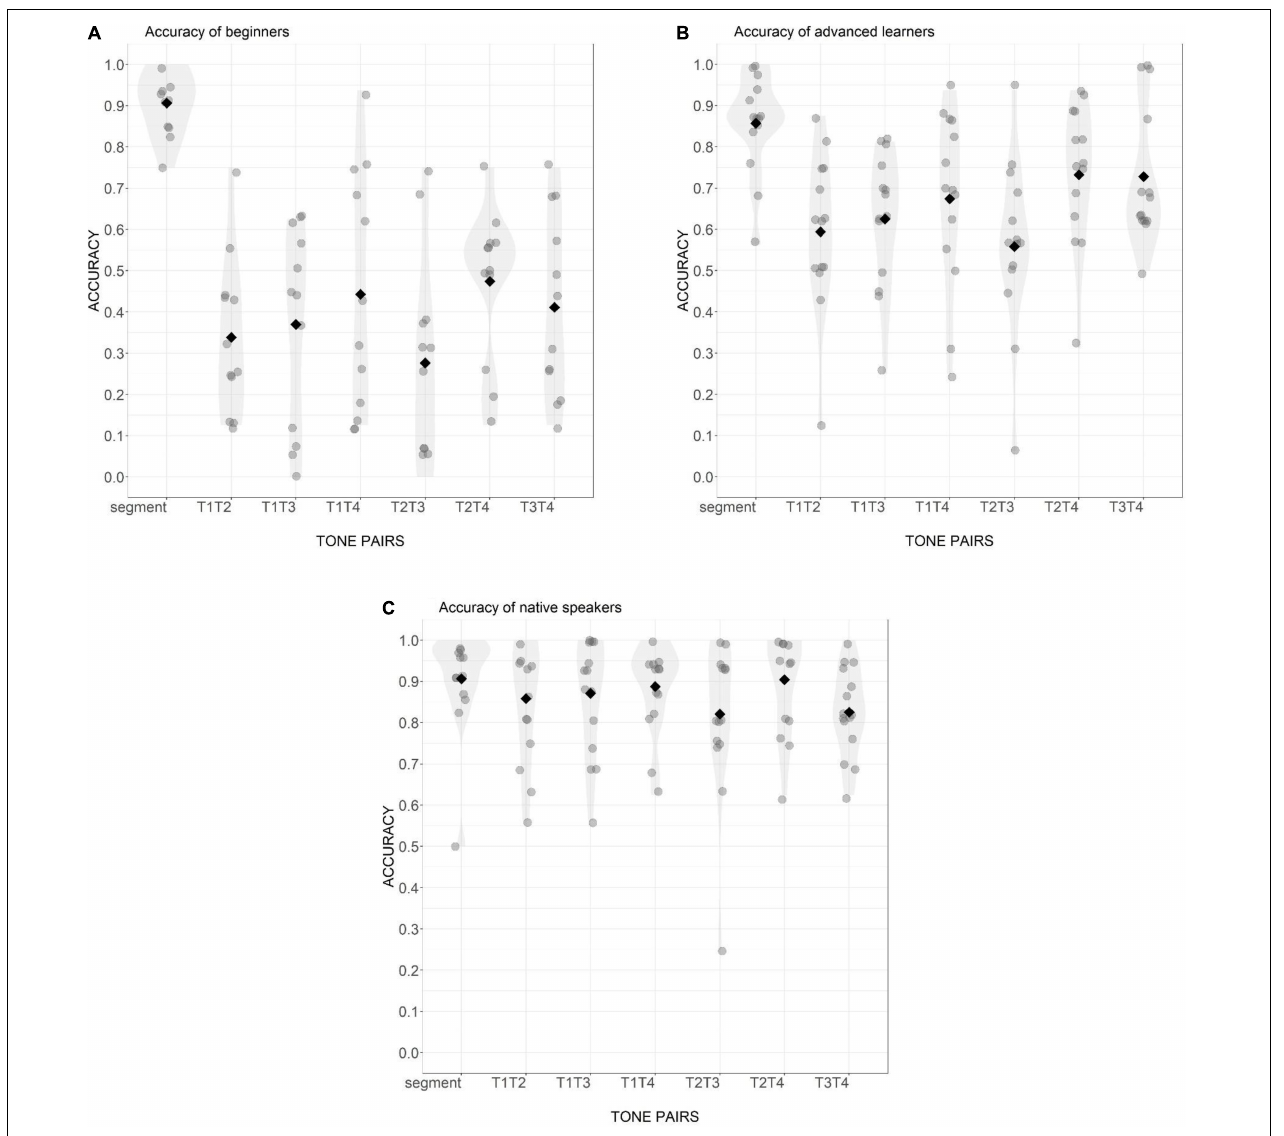
FIGURE 1 | Distribution of sequence-recall accuracy of beginning learners (A) , advanced learners (B) , and native Mandarin speakers (C) in six tone pairs and the segmental condition. Gray points are individual participant means. Black diamonds are condition means.